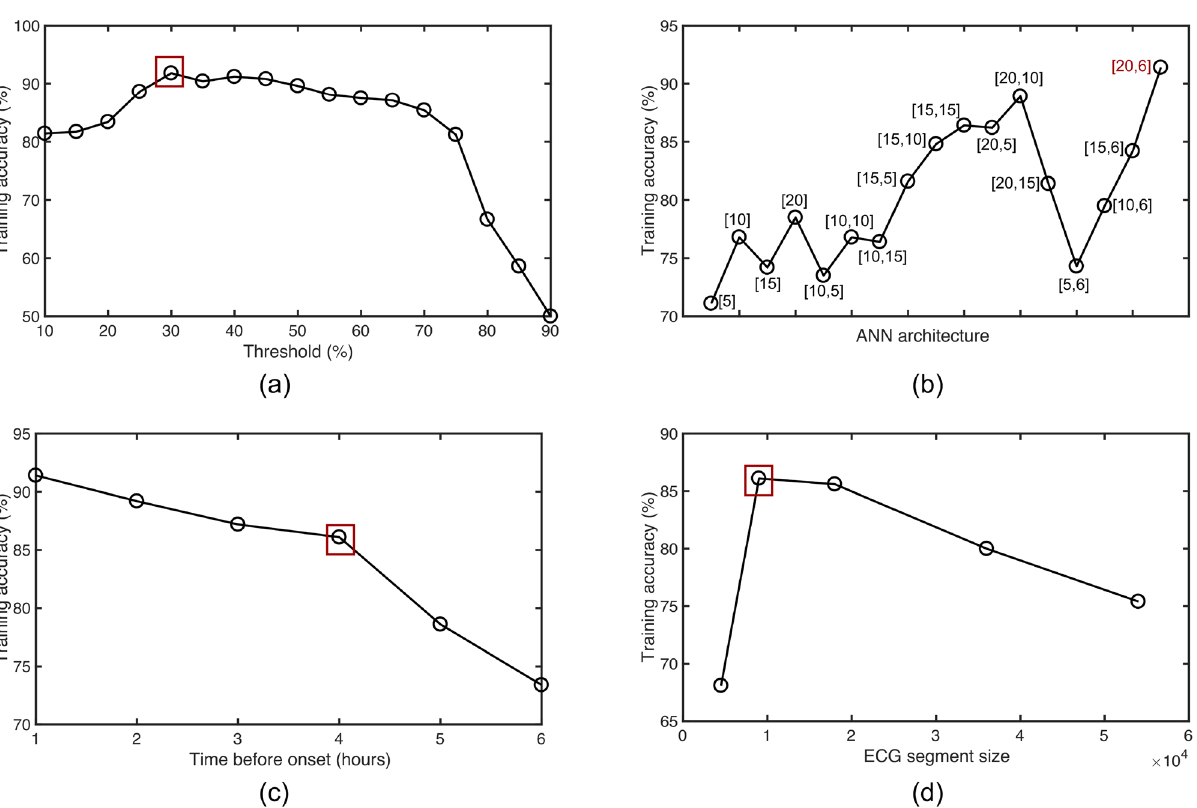
Figure 6. Training accuracy vs ( a ) threshold for detecting R peaks ( b ) ANN architecture ( c ) time before sepsis onset ( d ) ECG segment